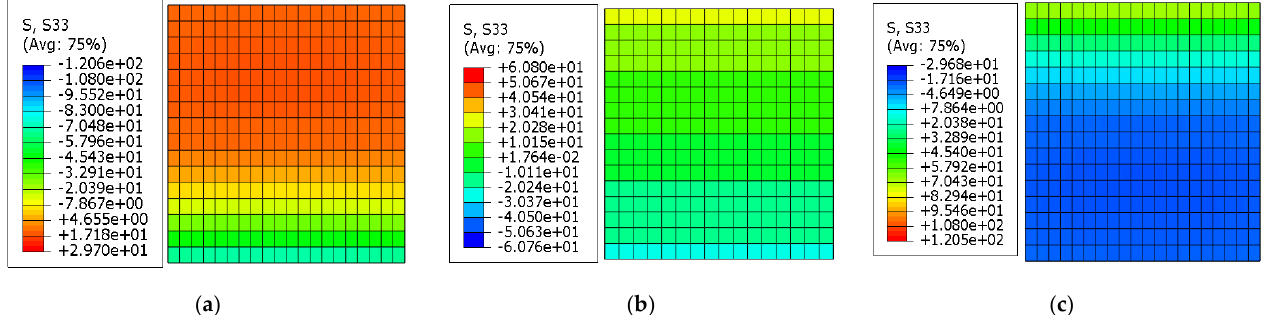
Figure 6. Numerical models for normal stress distribution in E-FGM beam ( a ) E 1 /E 2 = 10, ( b ) E 1 /E 2 = 1.0, and ( c ) E 1 /E 2 = 0.1.